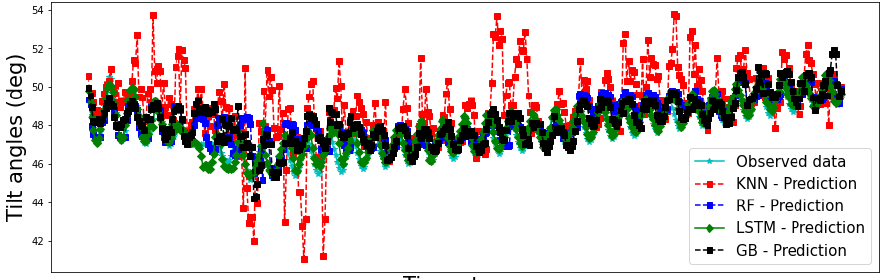
Figure 15. Comparison of nowcasts from KNN, RF, GB, and the LSTM for the randomly selected 31 days of testing